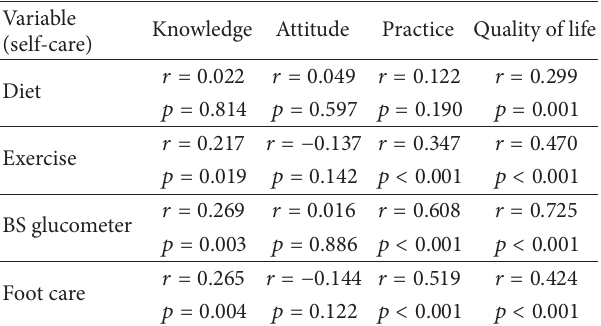
Table 4: Correlation of patients’ knowledge, attitude, practice, and quality of life with self-care